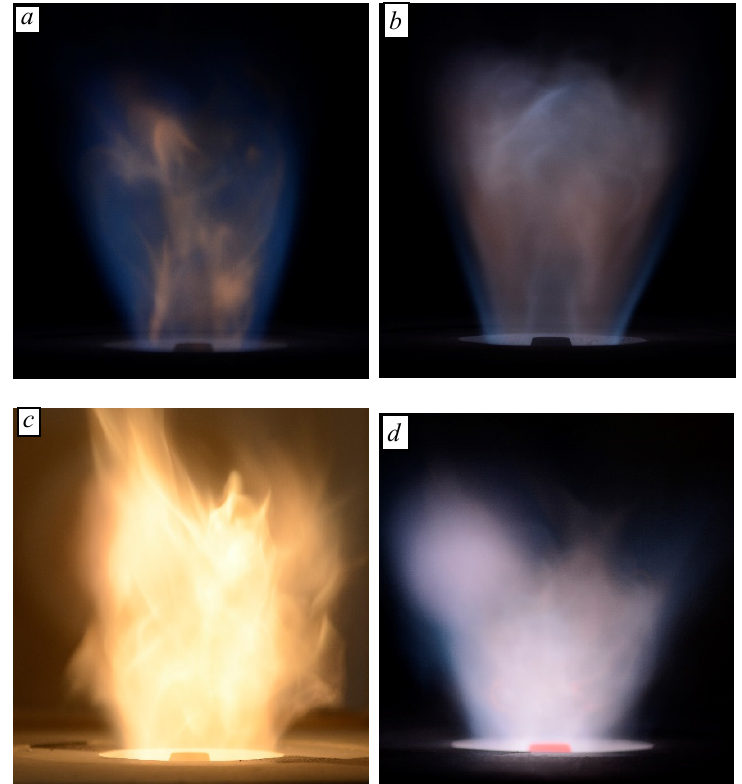
Figure 3. Images of methane ( a , c ) and syngas ( b , d ) flames at normal conditions ( a , b ) and elevated pressure and temperature ( c , d ).